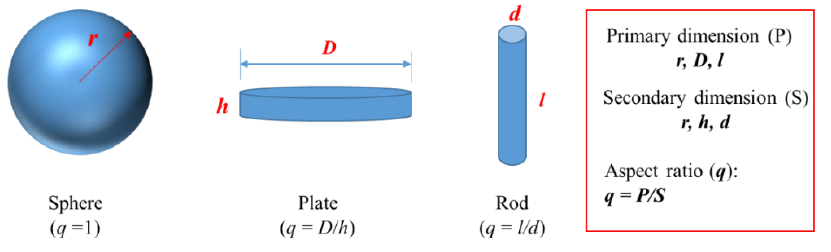
Figure 1. Summary of key dimensions of general precipitates.